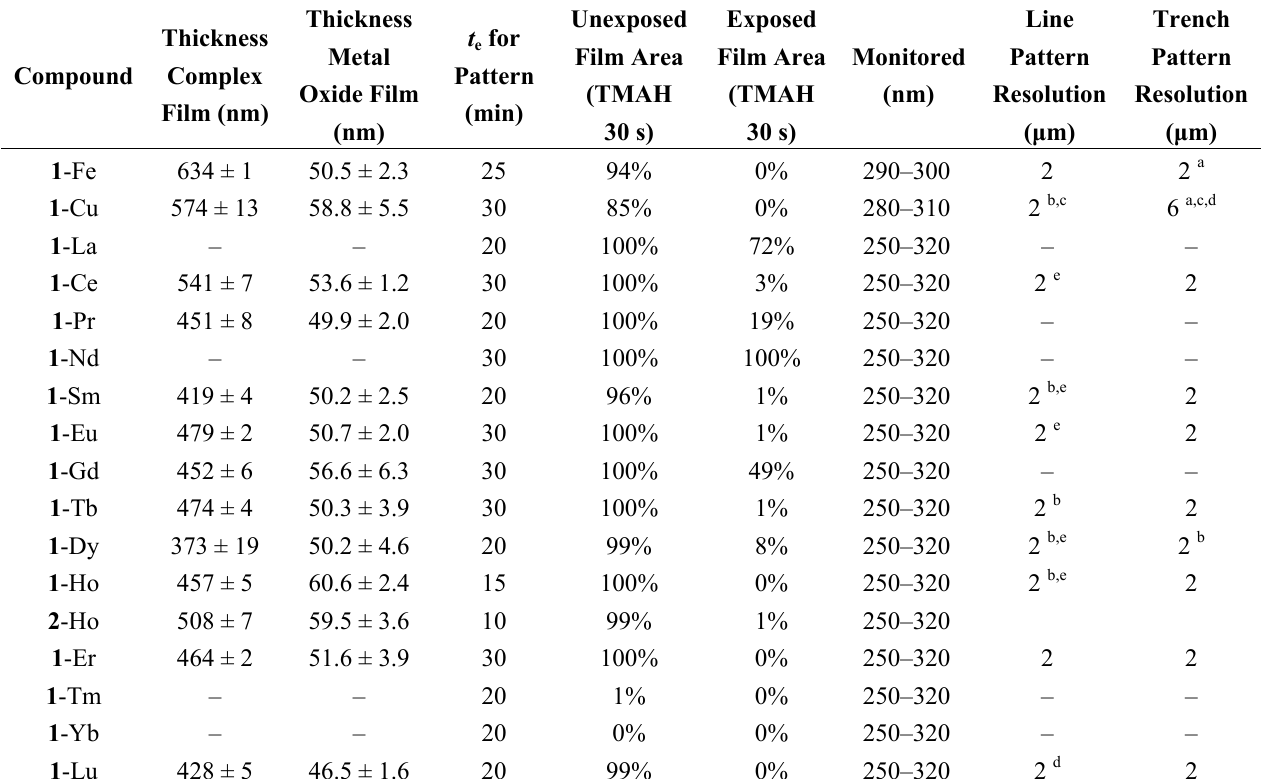
Table 1. Experimental parameters and observations of nitrobenzyl 3,4-dihydroxybenzoate metal complex film